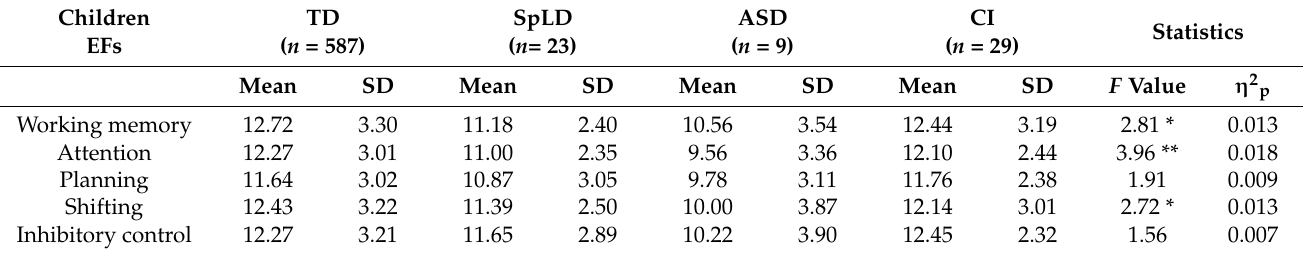
Table 4. Scores of parental perception of children’s EF.